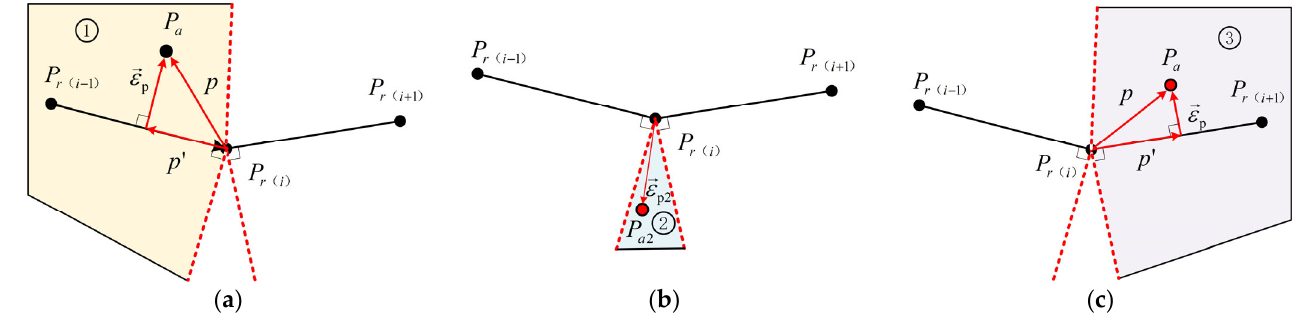
 → ε p and the vector p of P r , ( i ) P a in three cases. ( a ) Case 1; and the vector p of